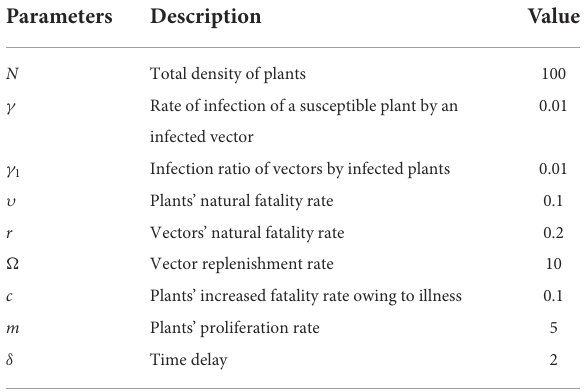
TABLE 1 Description and default parameters setting of for non-linear PVPMV [25].